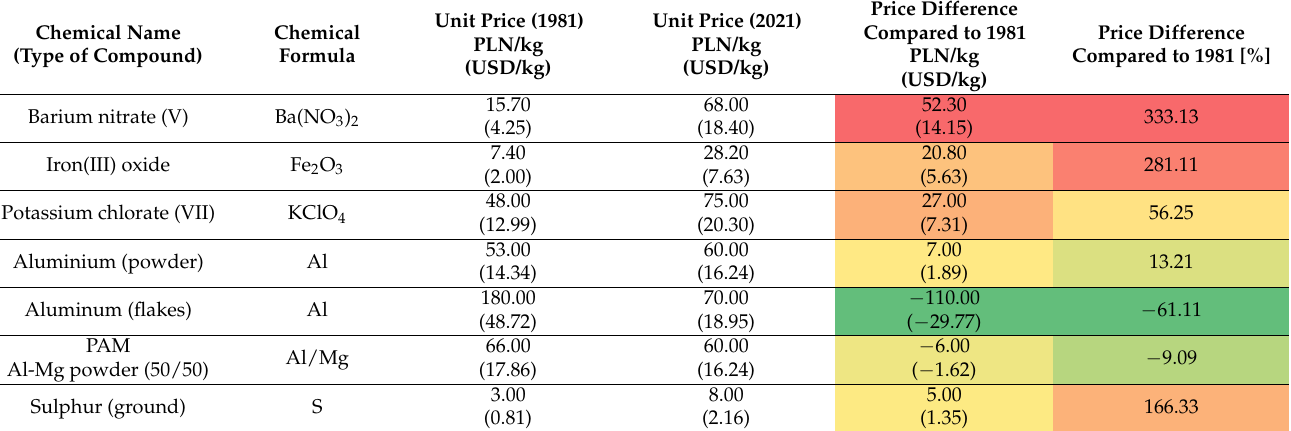
Table 3. Fluctuations of the unit price of pyrotechnic composition components in 1981 and 2021